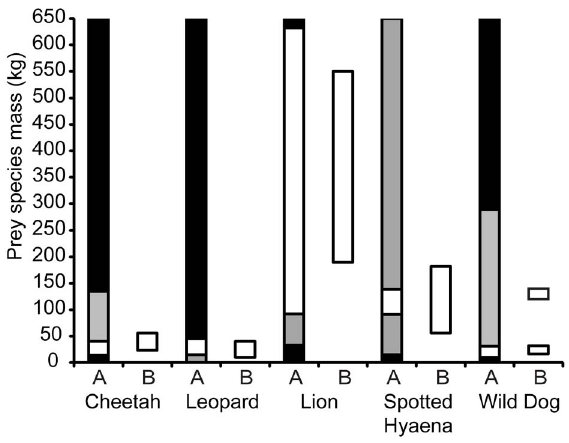
Figure 3. Prey weight preferences of the five large African carnivores. Weight ranges (below 650 kg) of prey species found to be preferred (white), killed relative to their abundance (grey) and avoided (black) by the five large African carnivores, determined (A) in this study and (B) in [5–9].